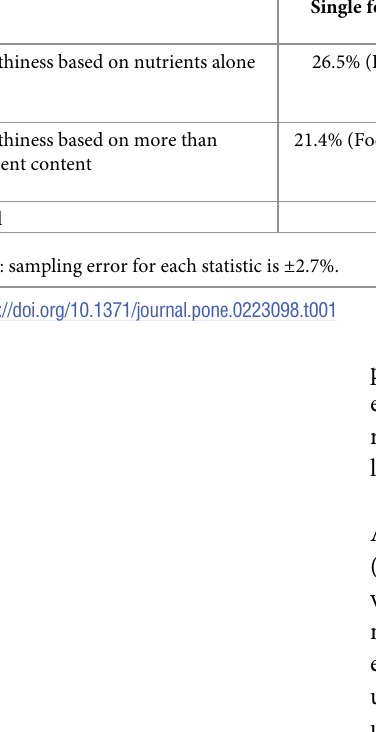
Table 1. Percent of respondents with four different views on how healthy should be defined.